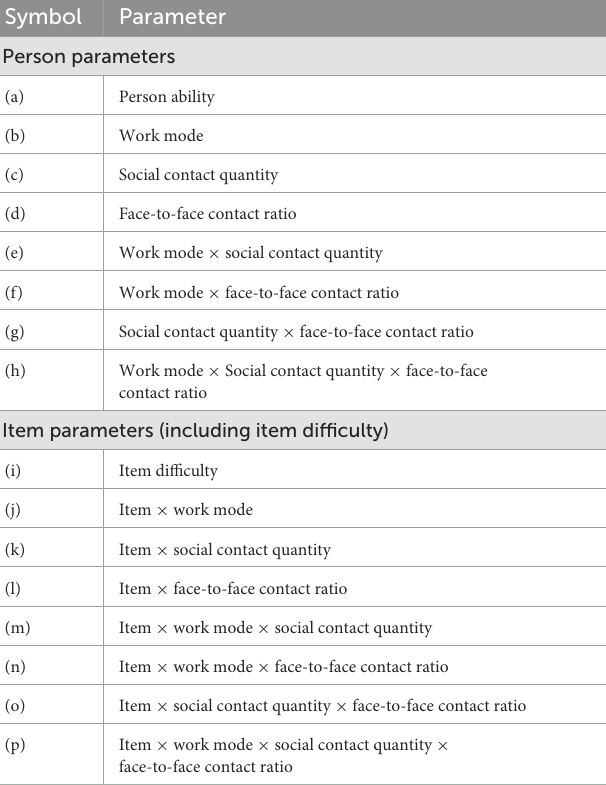
TABLE 1 Estimated parameters in the